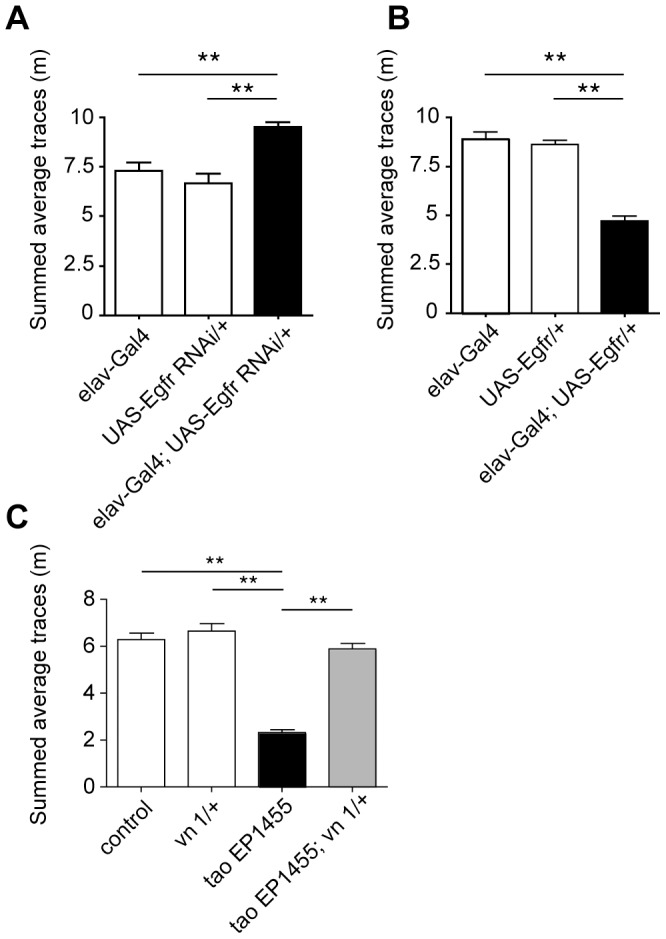
Egfr expression level in neurons affects ethanol-induced locomotion.(A) Ethanol induced locomotion of flies overexpressing wild-type Egfr in neurons, under the control of elav-Gal4, compared to single transgenic controls. (B) Ethanol-induced locomotion of flies with RNAi-mediated knockdown of Egfr expression in neurons, compared to single transgenic controls. (C) Ethanol-induced locomotion of taoEP1455; vn1/+ flies, compared to single mutants and wild-type control. **p<0.01, One-way ANOVA with Neuman-Keuls post-hoc test.